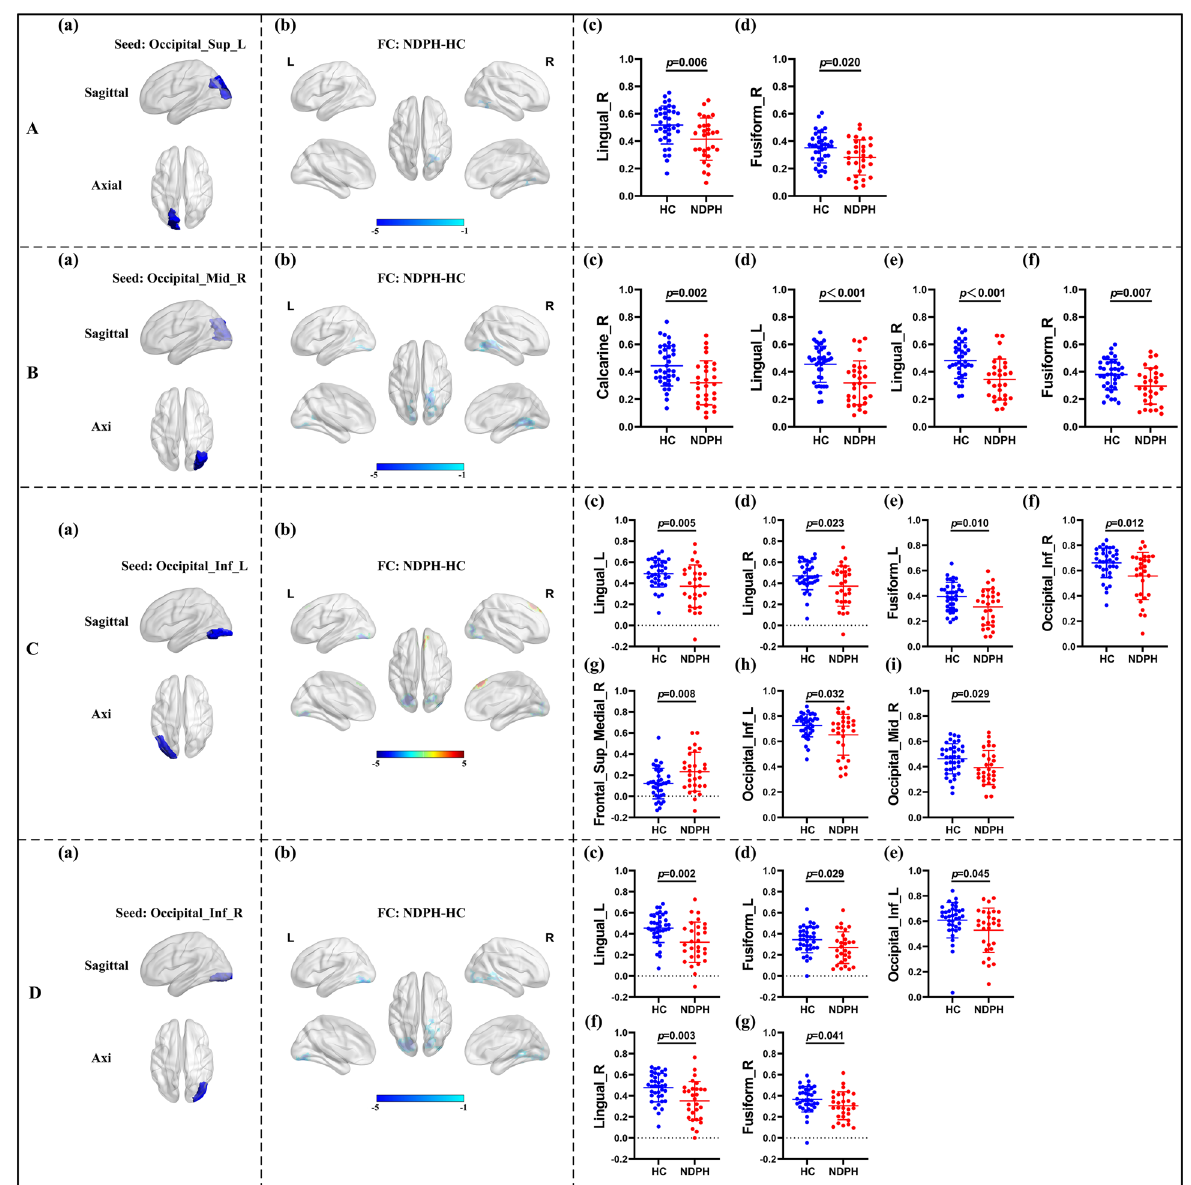
Fig. 2 FC analysis from occipital lobe to the whole brain voxels in NDPH and HC groups. A (a) The schematic diagram of the seed (left superior occipital gyrus). (b) Compared with HCs, patients with NDPH showed significantly decreased FC between the left superior occipital gyrus and right lingual gyrus, right fusiform gyrus. (c) and (d) represented FC values between the seed and right lingual gyrus, right fusiform gyrus respectively in HCs and patients with NDPH. B (a) The schematic diagram of the seed (right middle occipital gyrus). (b) Compared with HCs, patients with NDPH showed significantly decreased FC between the seed and bilateral lingual gyrus, right calcarine, right fusiform gyrus. (c) to (f) represented FC values between the seed and bilateral lingual gyrus, right calcarine, right fusiform gyrus respectively in HCs and patients with NDPH. C (a) The schematic diagram of the seed (left inferior occipital gyrus). (b) Compared with HCs, patients with NDPH showed significantly decreased FC between the seed and bilateral lingual gyrus, left fusiform gyrus, bilateral inferior occipital gyrus, right middle occipital gyrus and increased FC between the seed and medial superior frontal gyrus. (c) to (i) represented FC values between the seed and bilateral lingual gyrus, left fusiform gyrus, bilateral inferior occipital gyrus, right middle occipital gyrus, medial superior frontal gyrus respectively in HCs and patients with NDPH. D (a) The schematic diagram of the seed (right inferior occipital gyrus). (b) Compared with HCs, patients with NDPH showed significantly decreased FC between the seed and bilateral lingual gyrus, bilateral fusiform gyrus, left inferior occipital gyrus. (c) to (g) represented FC values between the seed and bilateral lingual gyrus, bilateral fusiform gyrus, left inferior occipital gyrus respectively in HC group and patients with NDPH. Notes: The color bar showed t-values of the two-sample t-tests on FC. Abbreviations: L, left; R, right; FC, functional connectivity; Sup, superior; Mid, middle; Inf, inferior; NDPH, new daily persistent headache; HC, health